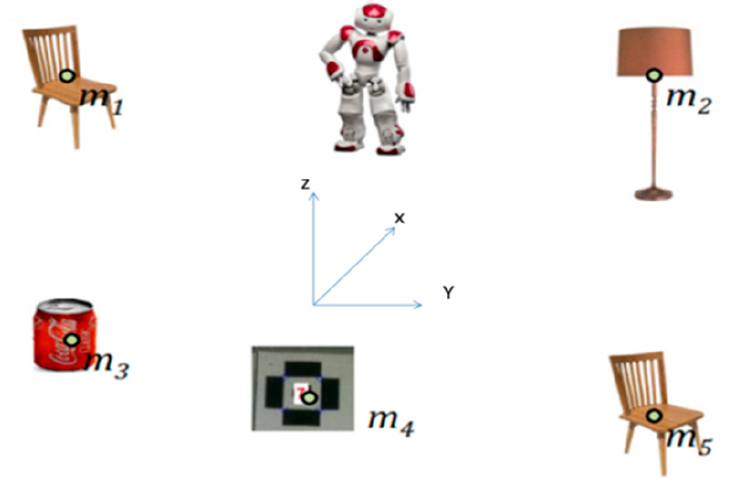
Figure 1. NAO robot in indoor environment performing SLAM.